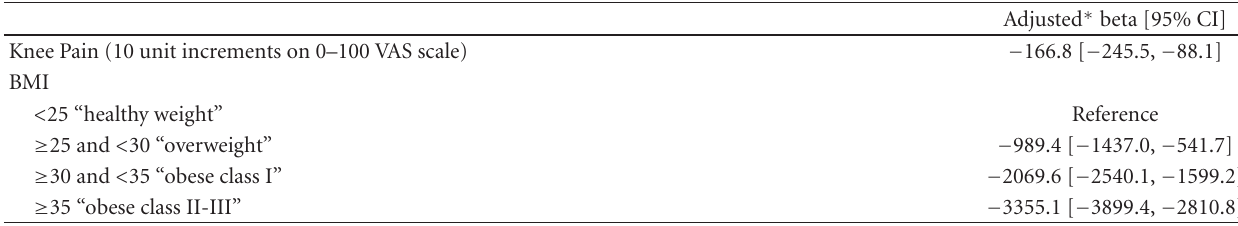
Table 2: Change in the number of daily steps attributed to pain and BMI after adjustment for covariates.